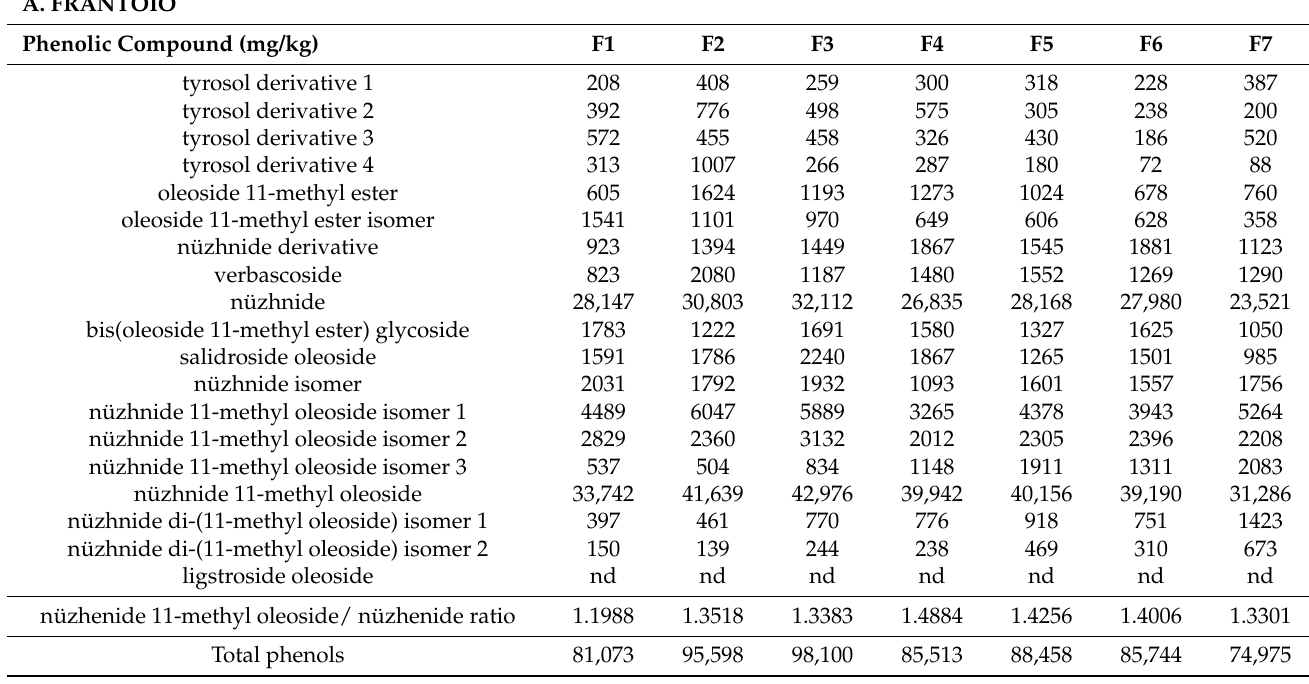
Table 2. Evolution of the content of phenolic compounds in seeds of olive fruits of the (A) Frantoio, (B) Moraiolo and (C) Leccino cultivars. Results are expressed in mg/kg of seed. The RSD was <5% (values determined as a mean of five replicates of a mixture of different